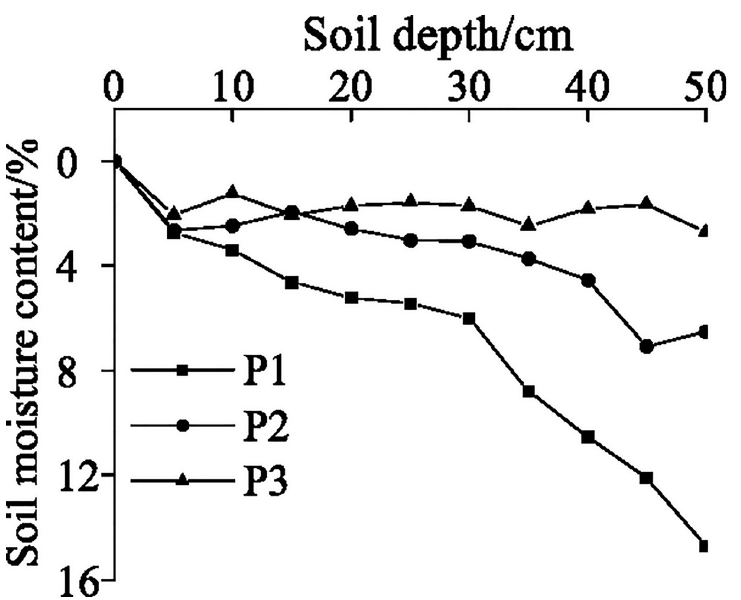
Fig 2. Soil water content at different slope positions.